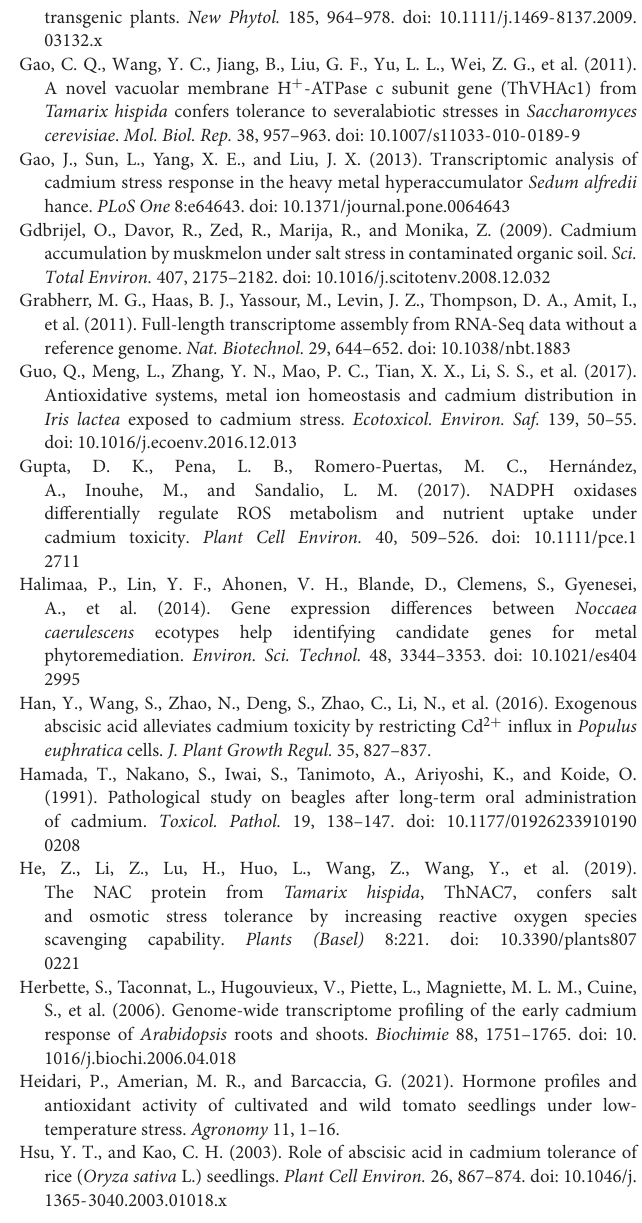
Supplementary Figure 1 | Signaling pathways involved in ABA. The genes associated with ABA were marked in different colors. Red: up-regulated genes. Blue: down-regulated